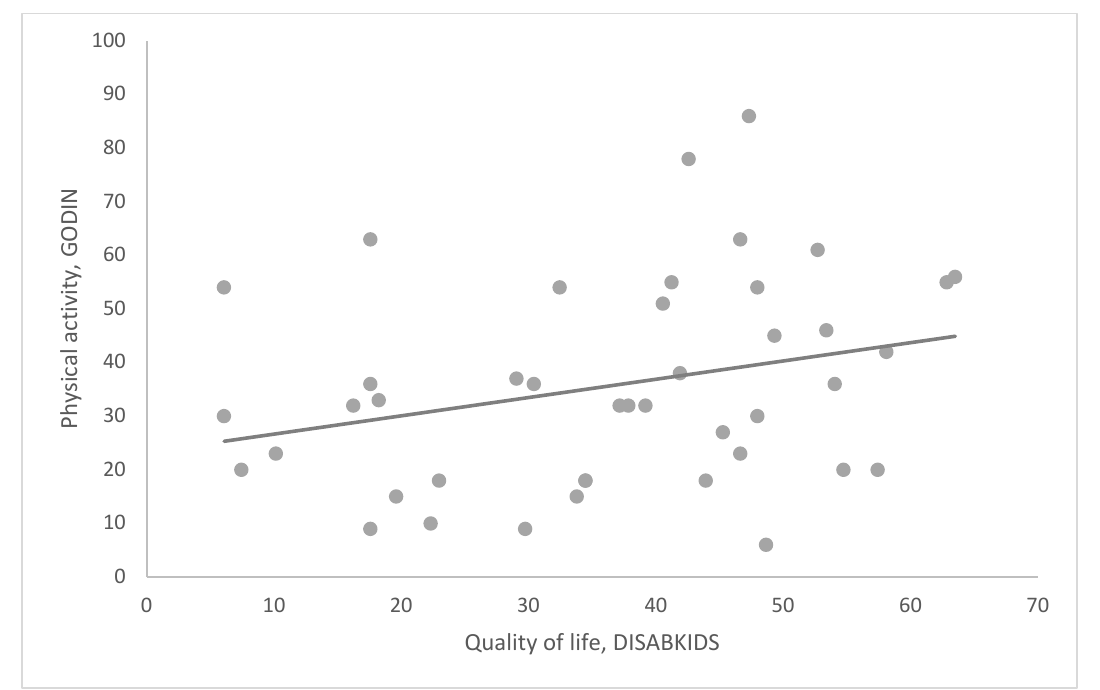
Figure 3. Patients with higher physical activity showed better emotional health (r: 0.414, p : 0.006).